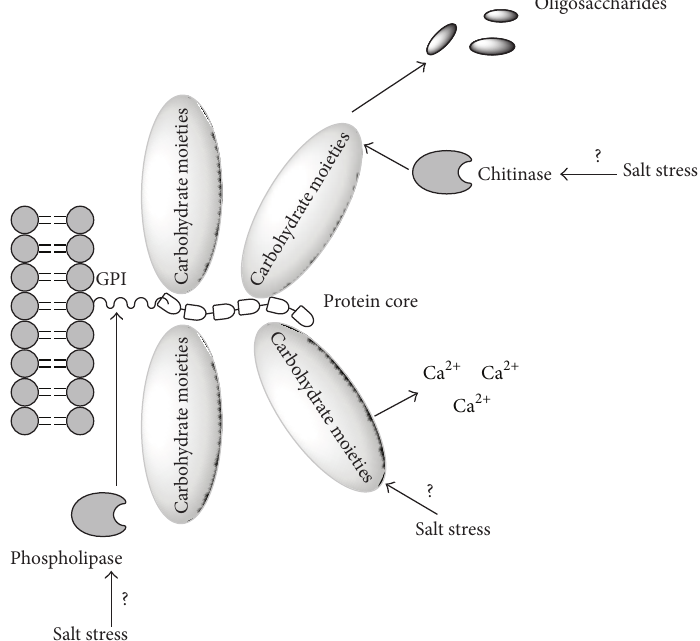
Figure 3: Three possible roles of the highly glycosylated arabinogalactan proteins (AGPs). (1) A specific phospholipase may cleave the glycosylphosphatidylinositol anchor (GPI) thus releasing AGPs into the cell wall and in the extracellular space. (2) AGPs may serve as storage molecules for Ca 2+ and release them in response to different stimuli thus activating Ca-dependent signal cascades. (3) N-acetylglucosamine containing carbohydrate branches may be targets for the action of plant chitinases thus releasing oligosaccharides with signaling or osmotic adjustment